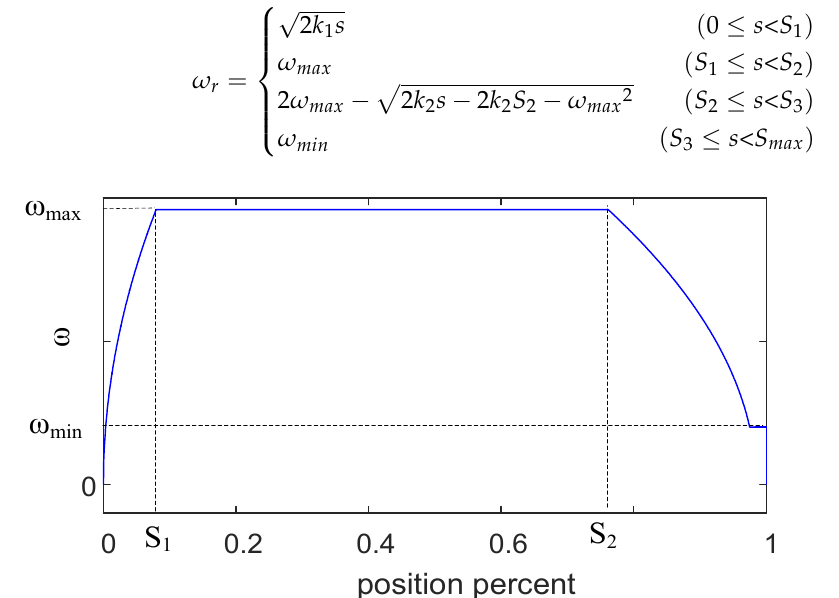
Figure 4. Speed and load curve according to the position.